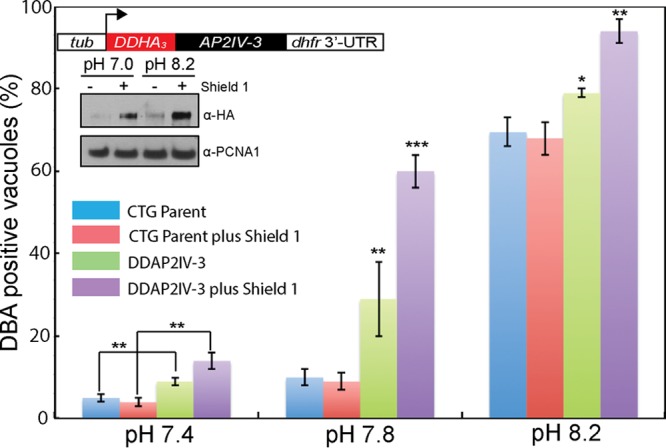
Overexpression of AP2IV-3 enhances tissue cyst formation. The 72-h capacity of the type III CTG parent strain to form tissue cysts compared to that of a CTG transgenic clone expressing DDAP2IV-3 was evaluated after a shift to mild-to-strong alkaline medium plus or minus Shield 1 at 100 nM, as indicated in the color key. The fraction of DBA-positive parasites in 100 randomly selected vacuoles was determined in triplicate. The increases in cyst formation by the DDAP2IV-3 parasites compared to that by the CTG parent control caused by alkaline stress alone or in combination with Shield 1 was statistically significant (*, P < 0.05; **, P < 0.01; ***, P < 0.001; pairwise data comparisons diagramed for the pH 7.4 data were repeated for the pH 7.8 and 8.2 data). Note also that type III CTG parental tachyzoites have a lower propensity to form tissue cysts spontaneously and are more resistant to milder alkaline pH medium conditions than Pru parental strain tachyzoites (Fig. 2B, blue bars). (Inset) Diagram of the DDAP2IV-3 overexpression construct and Western blot assay of DDAP2IV-3 expression with or without Shield 1. Note that DDAP2IV-3 was induced to detectable levels by pH 8.2 medium alone and to higher levels when Shield 1 was added to transgenic parasites grown in pH 7.0 and 8.2 media. The level of nuclear T. gondii PCNA1, as revealed by rabbit polyclonal antibody staining, was included as a loading control.